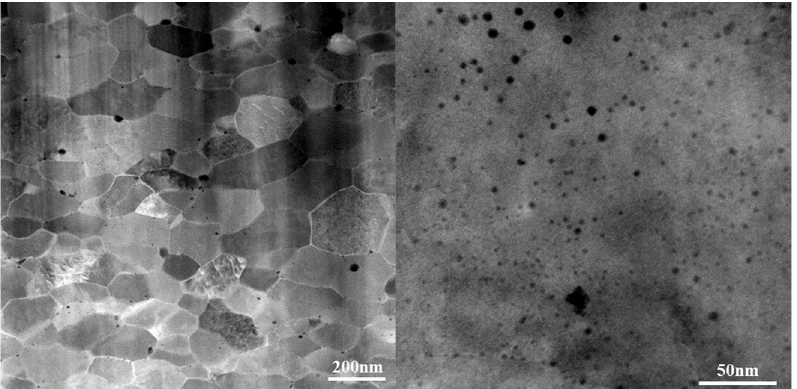
Figure 1. HAADF STEM (high-angle annular dark-field scanning transmission electron microscopy) images showing the microstructure of the 14YWT Alloy.